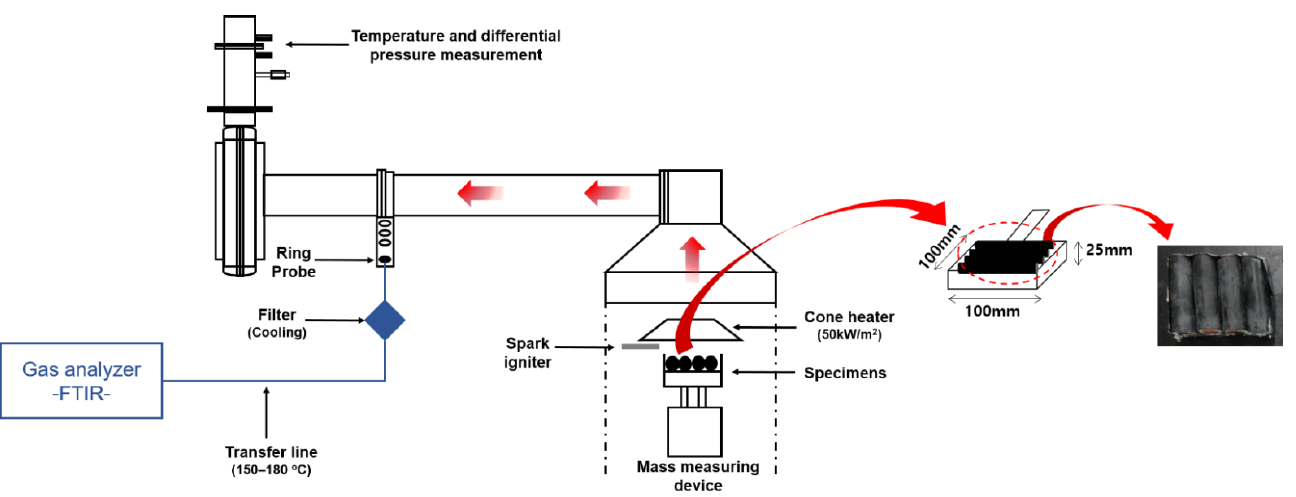
Figure 2. Schematic and specimen of a cone calorimeter FTIR (Fourier Transform Infrared Spectroscopy) test.